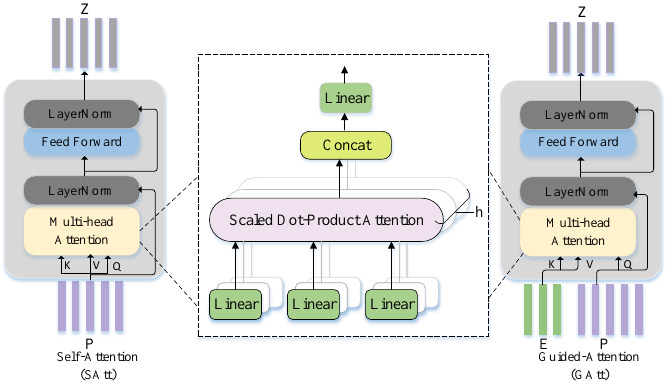
Figure 1. The composition of two basic components. The self-attention unit takes image features or question features as input, and the output feature is Z; the guided-attention unit adopts image features and question features as input, where image features are guided by the question features, and Z represents the output